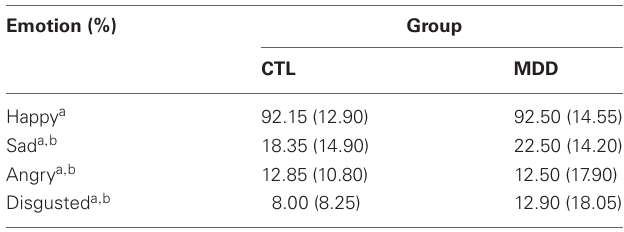
Table 2 | Percent trials emotional face judged friendlier than neutral face as a function of emotion and group.